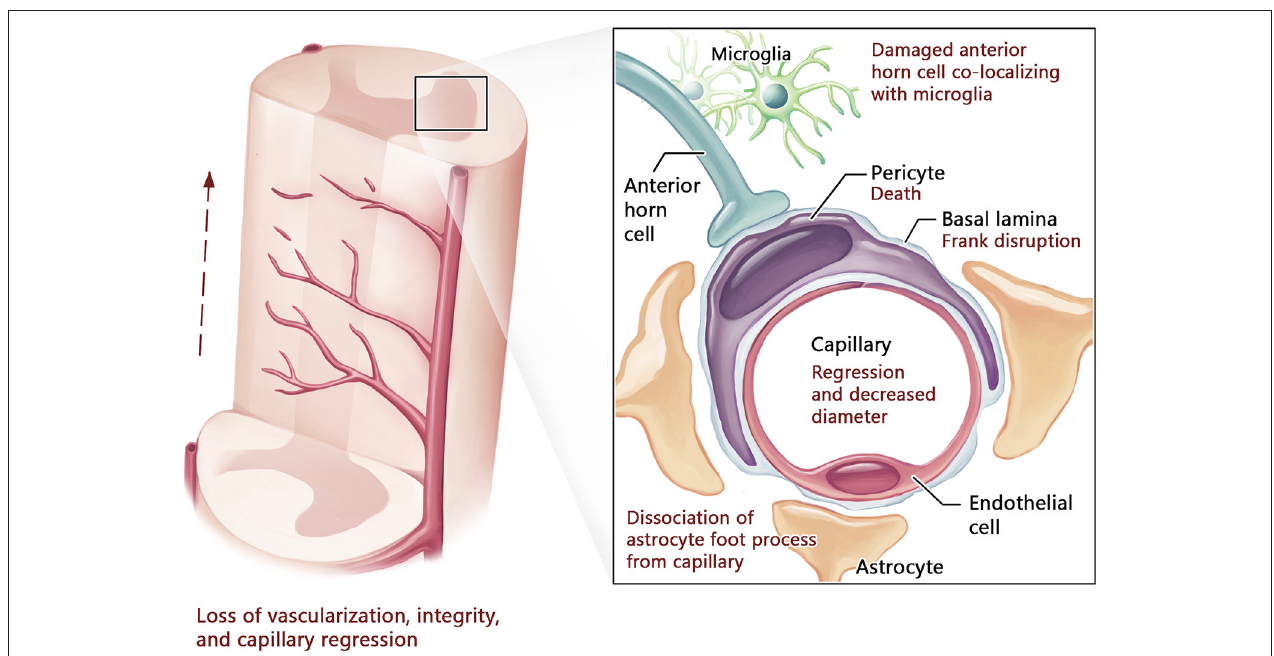
FIGURE 3 | Blood-spinal cord barrier structure in advanced stage of ALS. In advanced ALS, neurovascular compromise progresses with further capillary regression and decreased diameter leading to reduced vascularization, particularly in the anterior horn of the spinal cord. This is accompanied by pericyte death, basal lamina disruption, collagen IV deposition, and marked dissociation of astrocyte foot processes from capillaries. Damaged cells within the anterior horn co-localize with microglia, indicating